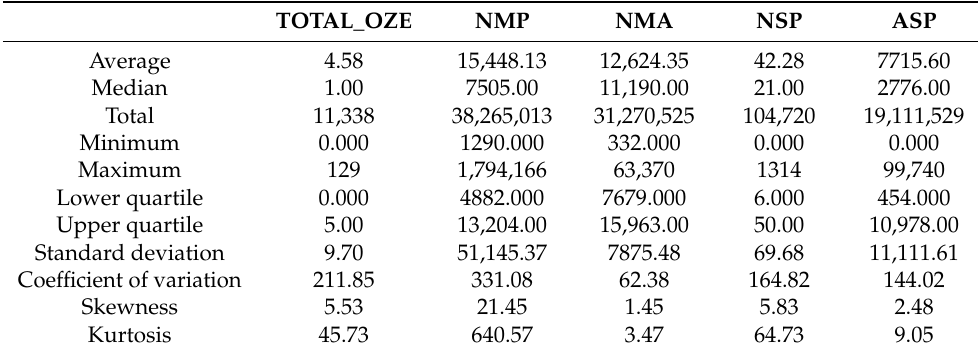
Table 2. Descriptive statistics of the variables